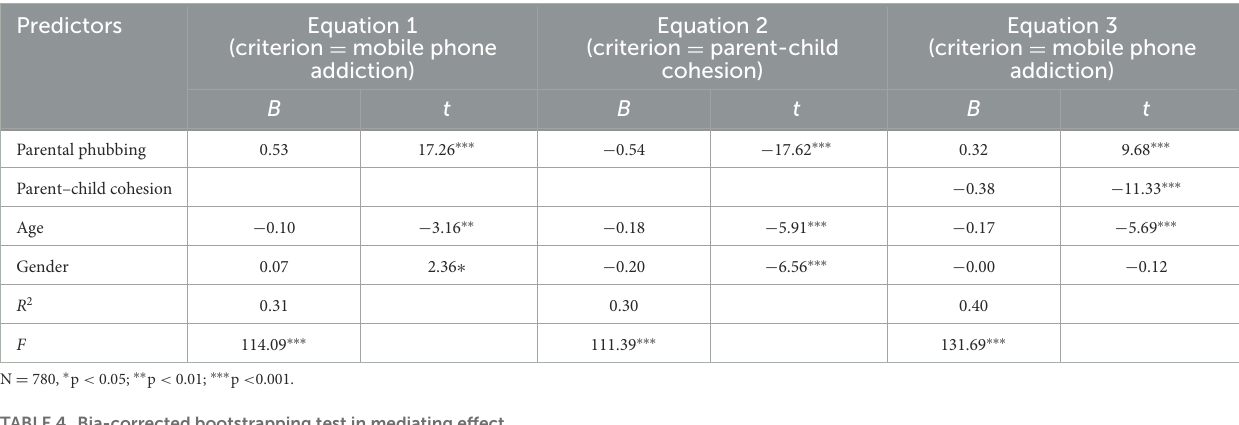
TABLE 4 Bia-corrected bootstrapping test in mediating effect.